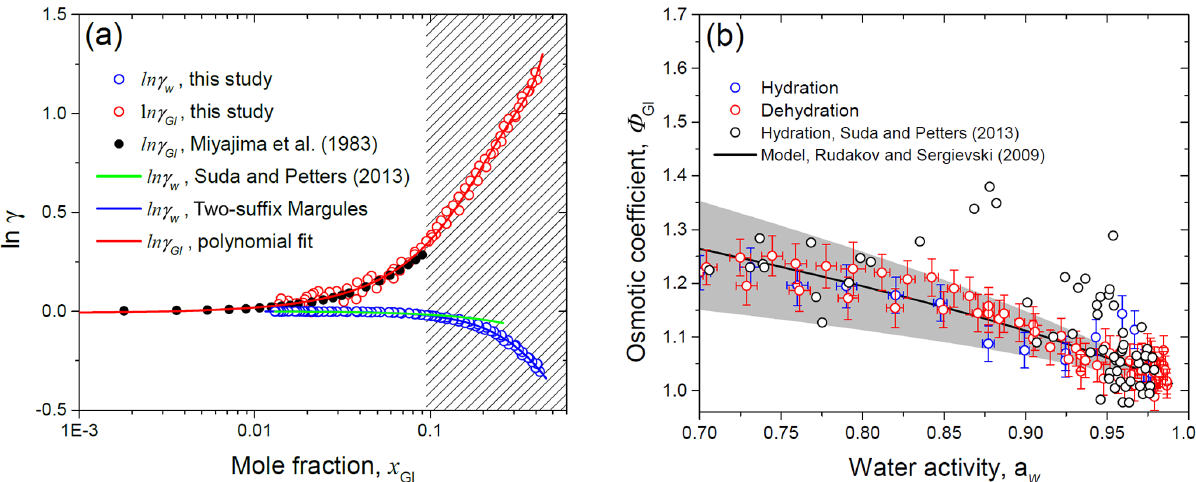
Figure 12. HHTDMA-based activity coefficients of water ( γ w ) and glucose ( γ Gl ) as a function of the mole fraction (a) and molal osmotic coefficient of glucose ( (cid:56) Gl ) vs. water activity (b) for glucose solution droplets in comparison with literature data. Bulk measurement of γ Gl from Miajima et al. (1983) – black solid (a) ; the data points and error bars are from the HHTDMA experiment with hydration (blue circles) and dehydration (red circles). The (cid:56) Gl values from Suda and Petters (2013) – black circles (b) . Model lines: (a) two-suffix Margules equation (Eq. 16, with A = − 1 . 957) – blue solid; (b) Rudakov and Sergievskii (2009) model (Eq. 23) with hydration number h 0 = 1 . 88 (the best-fit parameter with standard error is 0.04) – black solid. The gray shaded area denotes the hydration number range with h 0 + 0 . 5 (upper bound) and h 0 − 0 . 5 (lower bound). The red dashed fit line in panel (a) is the polynomial fourth-order fit function of ln γ Gl obtained in this study together with Miajima et al. (1983) bulk measurements. The shaded rectangle in panel (a) denotes the metastable area of the glucose solution droplet. Table 3. Fitted parameters ( ± standard deviation) of ln λ Gl as a function of the mole fraction of glucose, x Gl , in glucose aqueous solution; n and R 2 are the number of data points and the coefficient of determination of the fit,